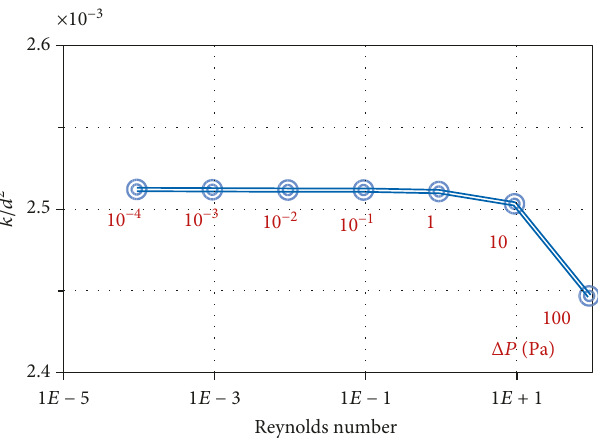
Figure 10: The permeability (normalized by d 2 ) for the di ff erent Reynolds numbers. The corresponding values of pressure drop Δ P are also shown in red (in